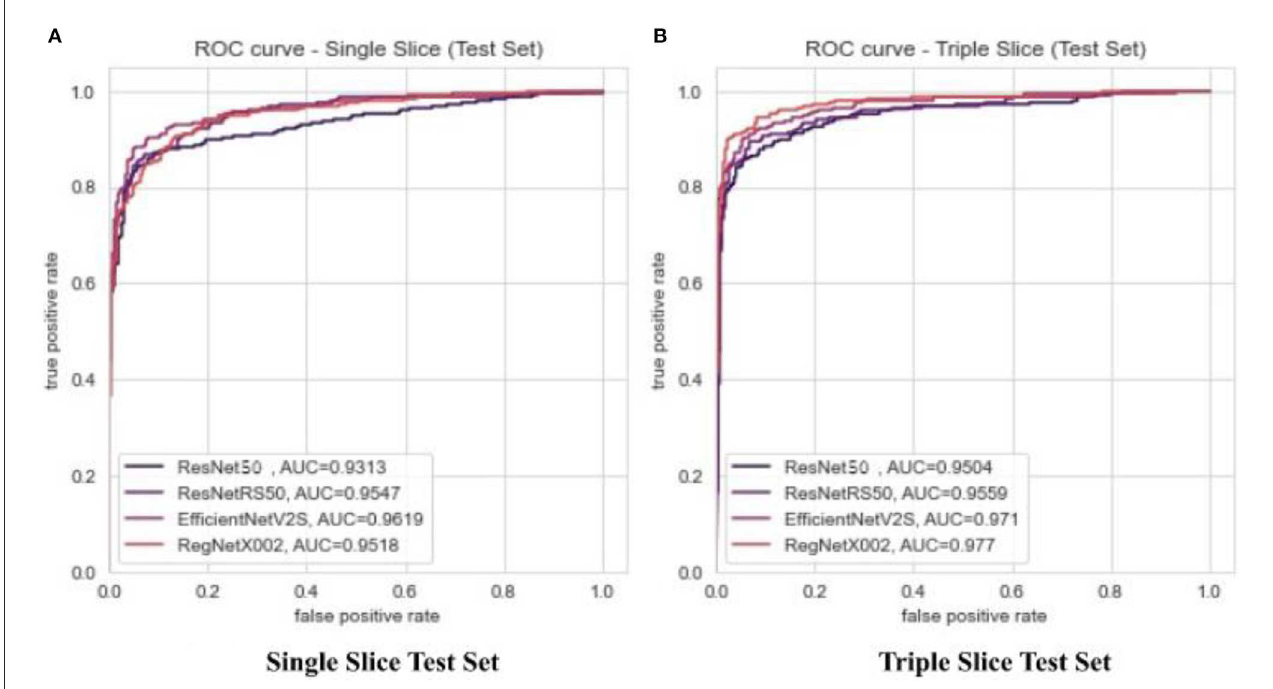
FIGURE3 ROC and AUC for binary classification of ResNet-50, ResNetRS-50, EfficientNetV2-S, and RegNet-X002. (A) Single slice test set ROC. (B) Triple slice test set ROC.